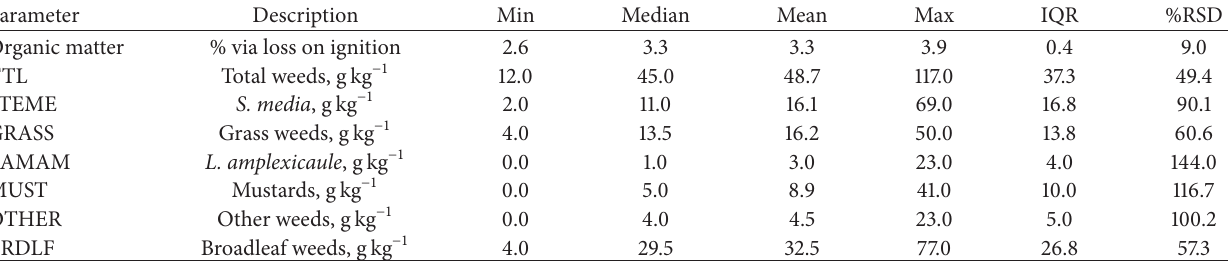
Table 1: Statistical summary for soil and weed parameters in the long-term reduced tillage experiment, Puyallup, WA, 2011.